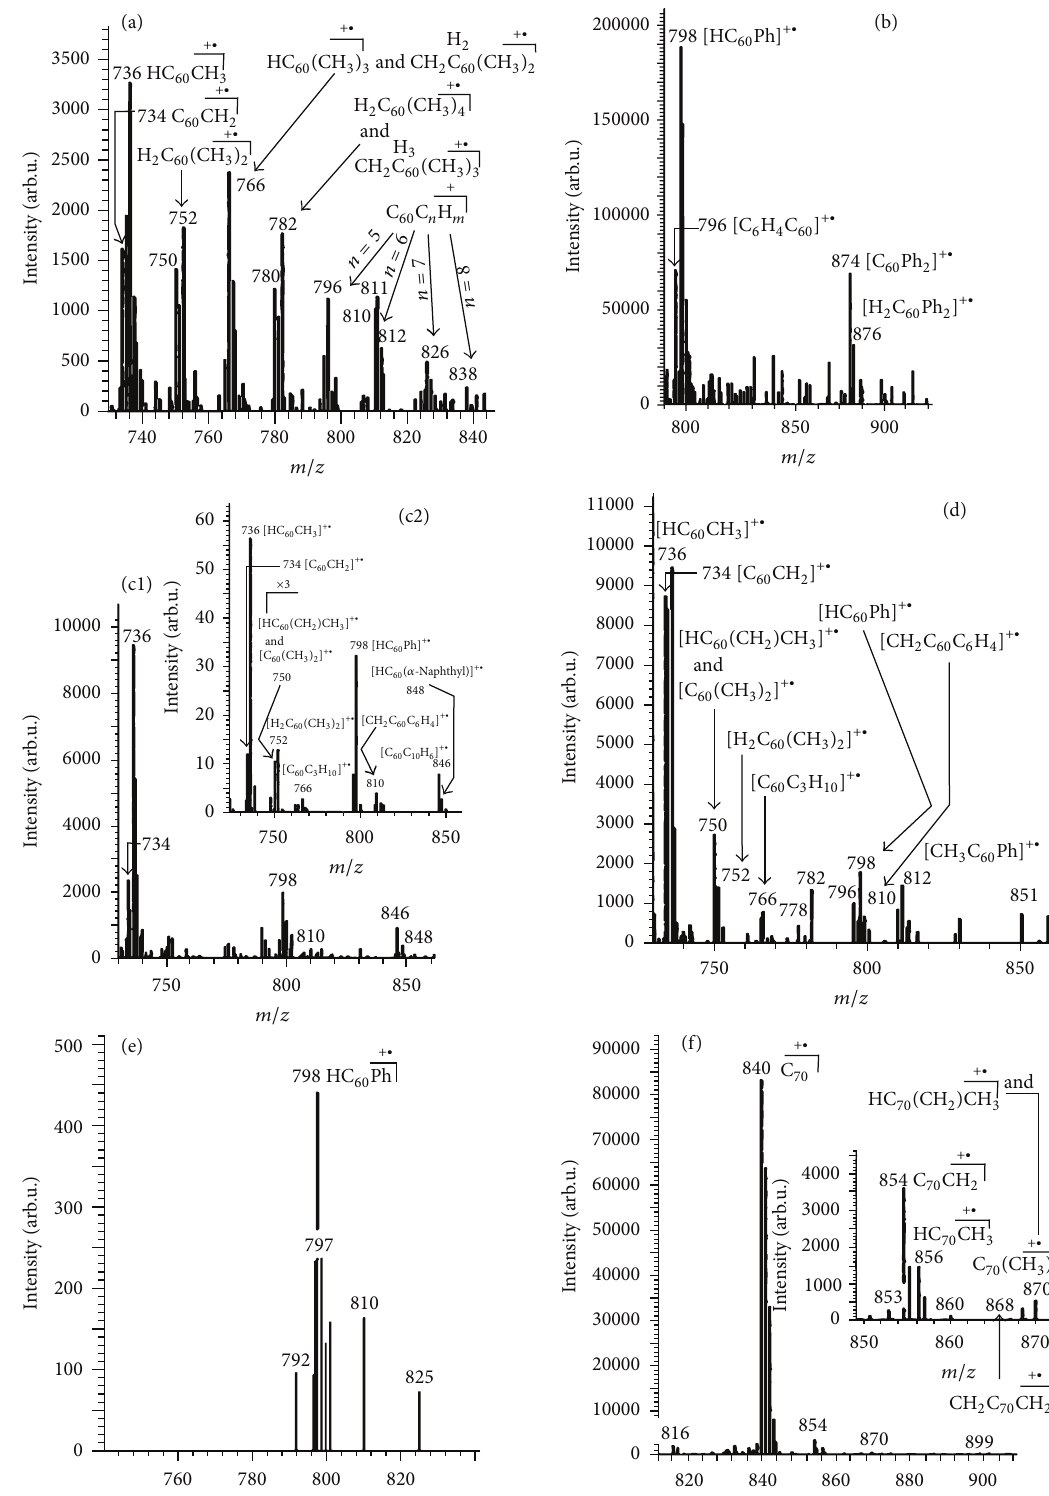
Figure 1: Electron ionization mass spectra in the high mass range from experiments in the IC of a mass spectrometer with C 60 and (a) tetramethylsilane ( 1 ), (b) tetraphenylsilane ( 4 ), and (c1 and c2) 𝛼 -naphthylphenylmethylsilane ( 5 ): (c1) one-scan mass spectrum and (c2) monoisotopic ( 12 C, 1 H) spectrum derived from the spectrum obtained by peak-summarizing over 101 magnetic scans (the background